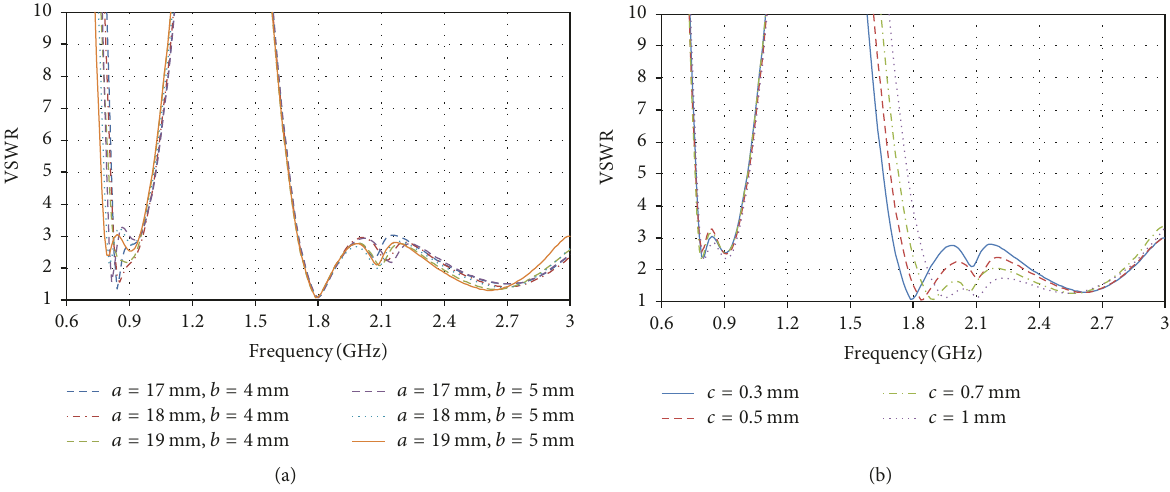
Figure 3: Simulated VSWR of the proposed antenna with variations of (a) the gap on the large folded plate and (b) the vertical strip line.